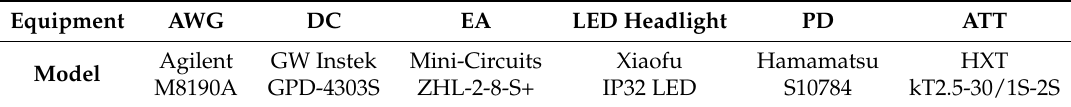
Figure 2. The experimental setup. Table 1. The experimental equipment.